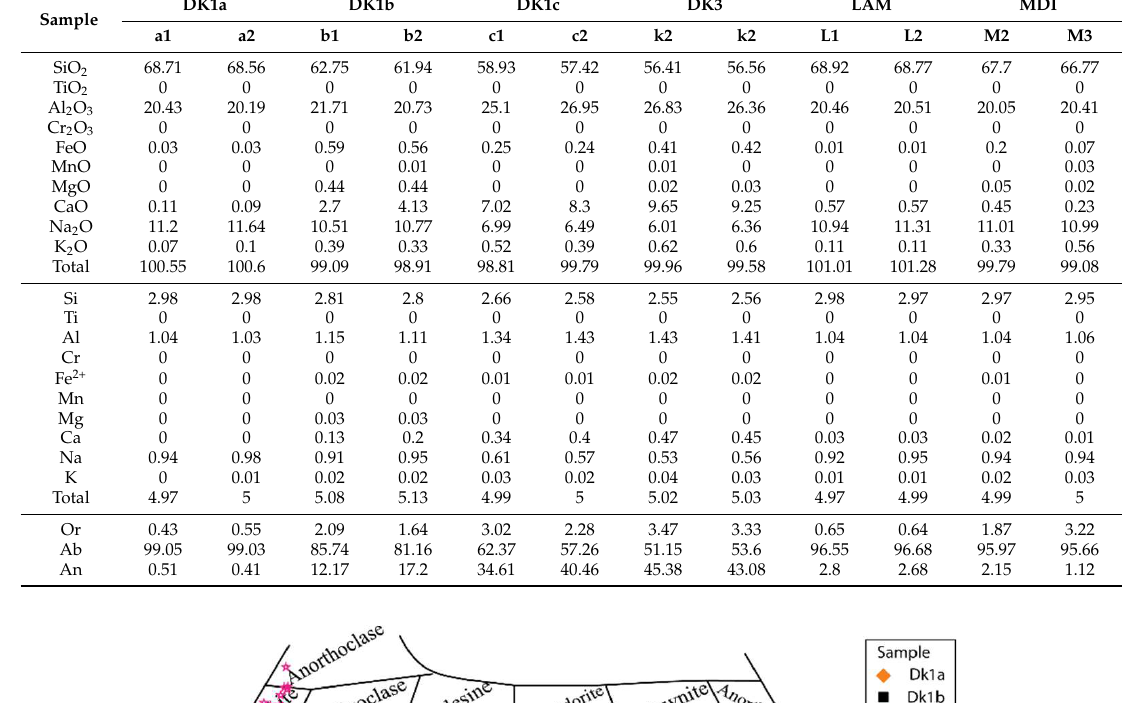
Table 1. Representative microprobe analyses of plagioclases. Cations calculation is based on 8 oxygen. Sample